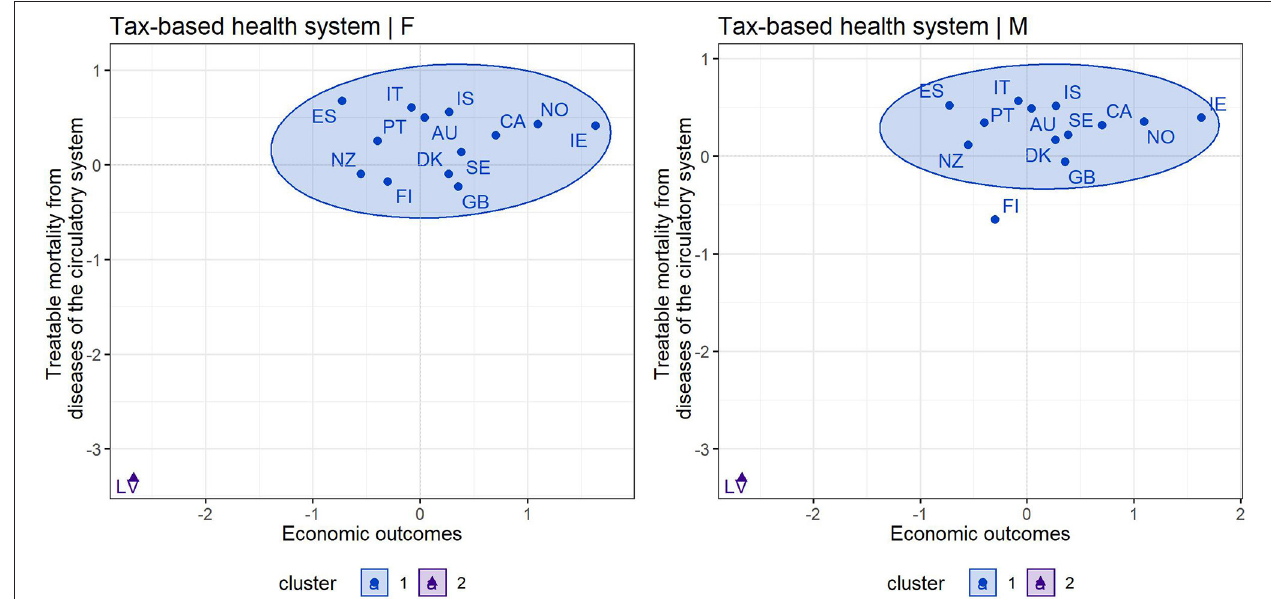
FIGURE 2 | Cluster map—economic outcomes and treatable mortality from circulatory system diseases for countries applying an insurance-based health system—females (F) and males (M).